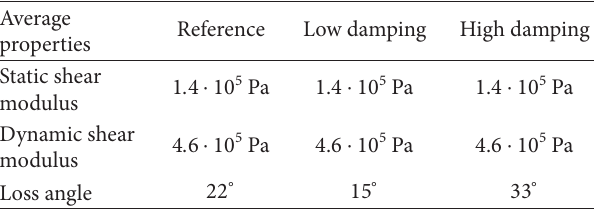
Table 3: Viscoelastic material properties of the reference, low damping, and high damping models.